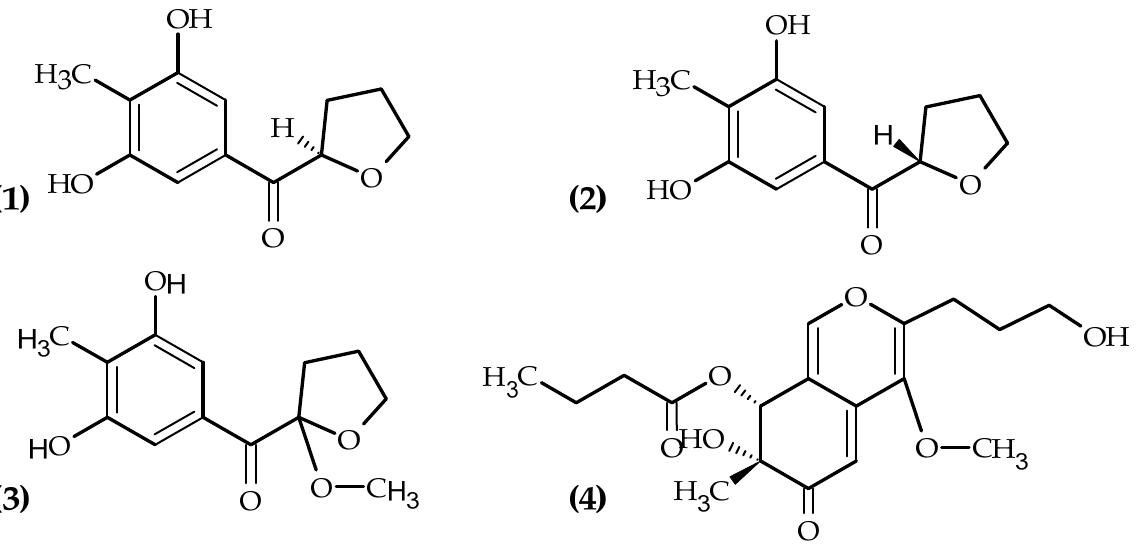
Figure 4. New compounds isolated from fungus Myrothecium sp. BZO-L062 : ( − )-(1S)-myrotheciol ( 1 ), (+)-(1R)-myrotheciol ( 2 ), 1-methoxy-myrotheciol ( 3 ), and myrothin ( 4 ).